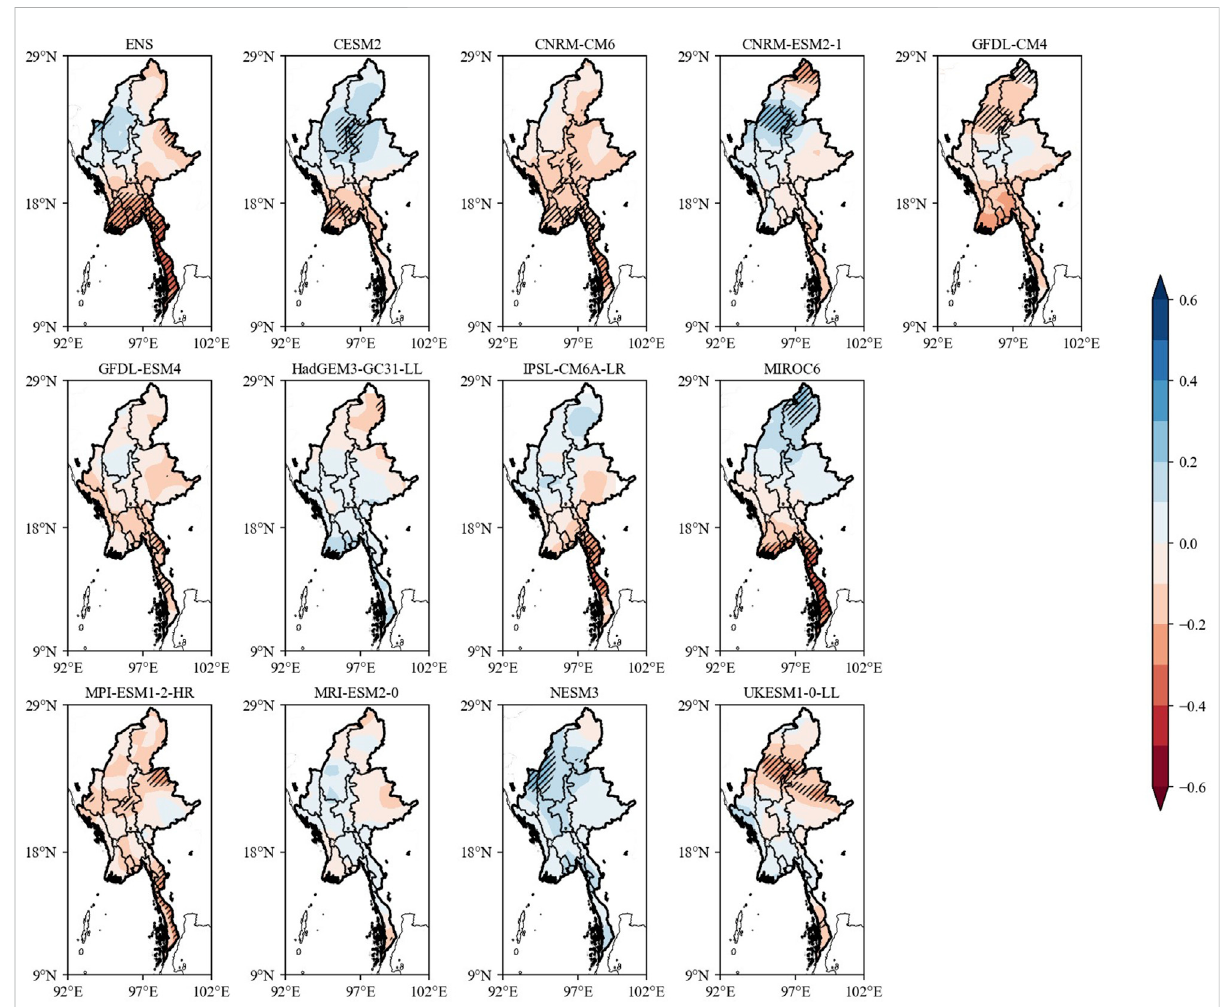
FIGURE 13 MK trend test of annual precipitation for the selected 12 CMIP6 models, and ENS. Hatches indicate signi fi cance at the 90% con fi dence